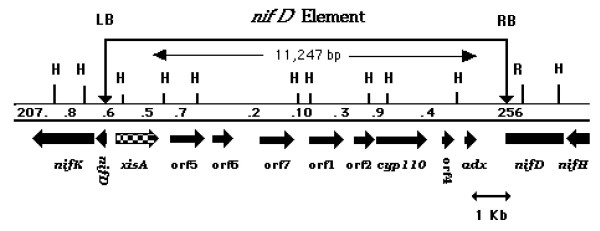
Genetic Map of the nif D Element. The positions of known nif D element genes and other open reading frames are indicated with arrows showing the orientation. LB = left border, RB = right border, H = HindIII sites. The numbers inside the double lines designate the HindIII fragment subclones of the nifD element derived from a 17 kbp EcoRI fragment, An 207. The cyp110 probe was made from the An207.4 HindIII fragment. The complete sequence of the nif D element is deposited in Genbank (U38537).